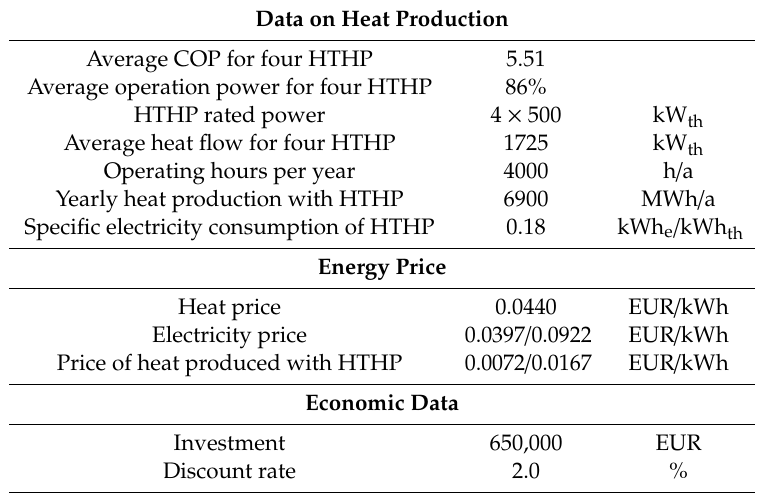
Table 4. Basic operating data of the high-temperature heat pump (HTHP), energy prices and other economic